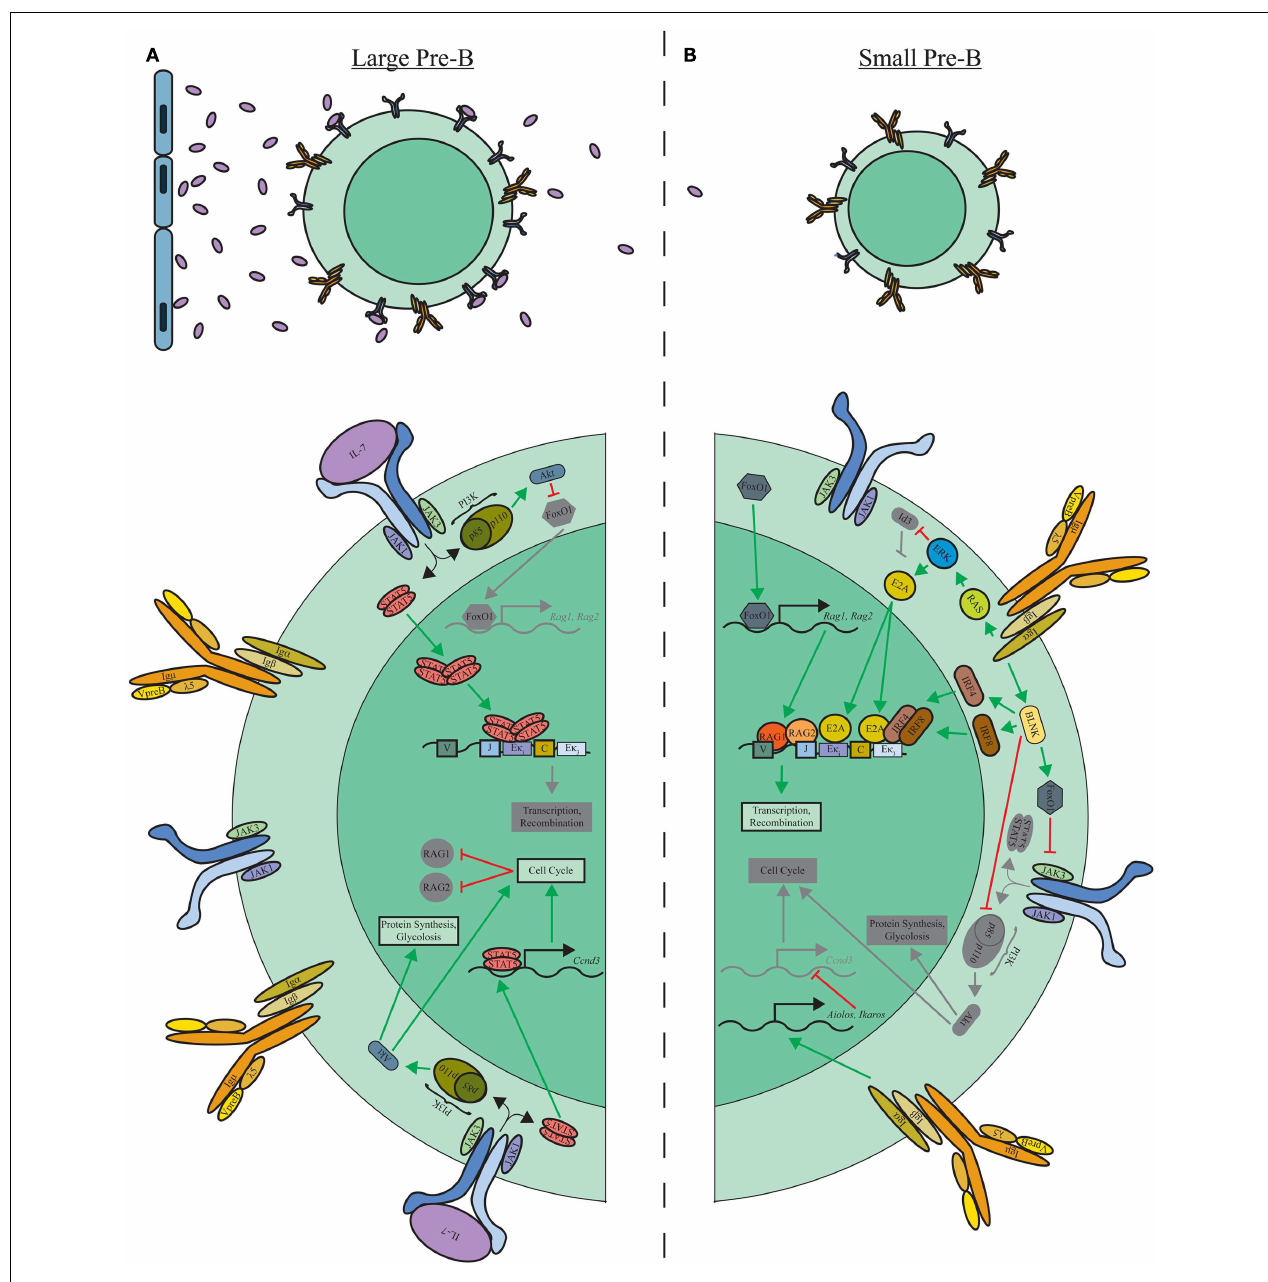
Ras/ERK and BLNK signaling modules to promote E2A and IRF4/IRF8 induction. Binding of these transcription factors to Ig κ enhancer elements enables recombination in small pre-B cells. Additionally, the BLNK module, along with Aiolos and Ikaros, downstream of the pre-BCR inhibit proliferation by repressing IL-7R expression, PI3K/Akt activation, and Ccnd3